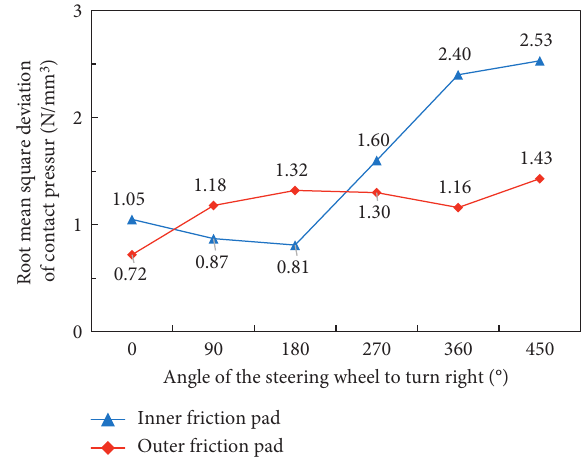
Figure 11: Root mean square deviation of contact pressure.